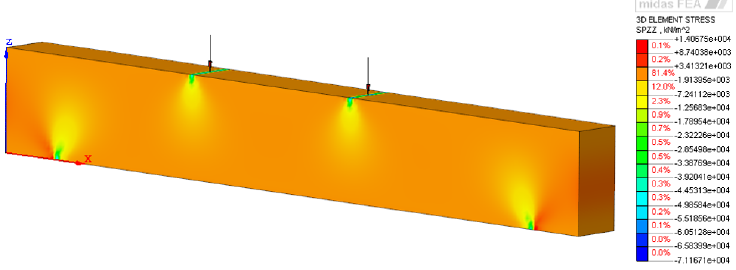
Figure 7. The strain distribution